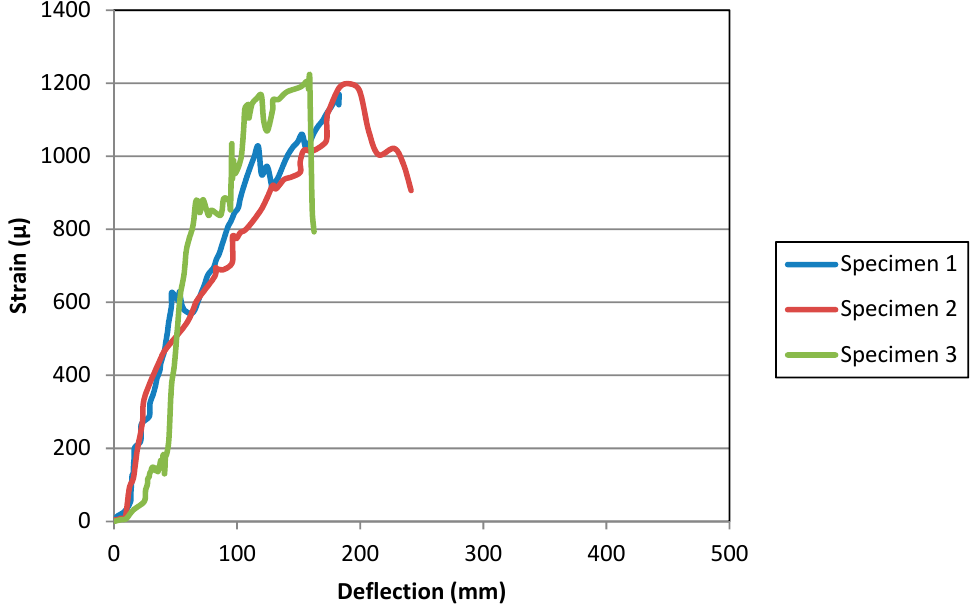
Figure 26. Strain versus deflection for the three specimens.